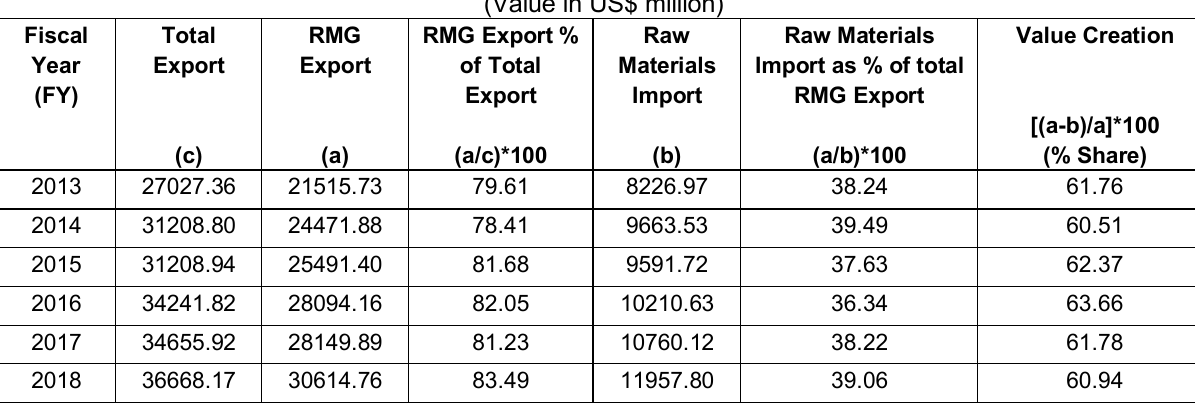
Table 4: Trends of Value Creation from RMG Export in the Context of Raw Materials Import (Value in US$